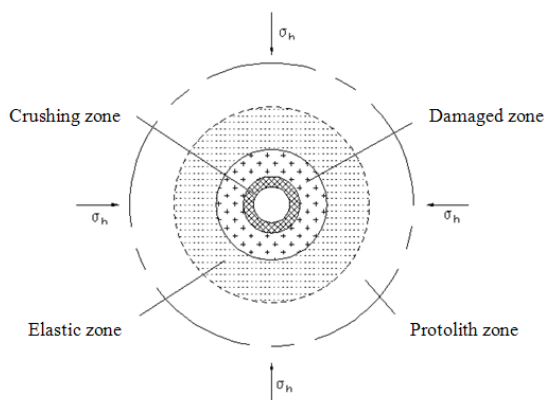
Figure 1: Damage zone of wall rock in the uniform ground